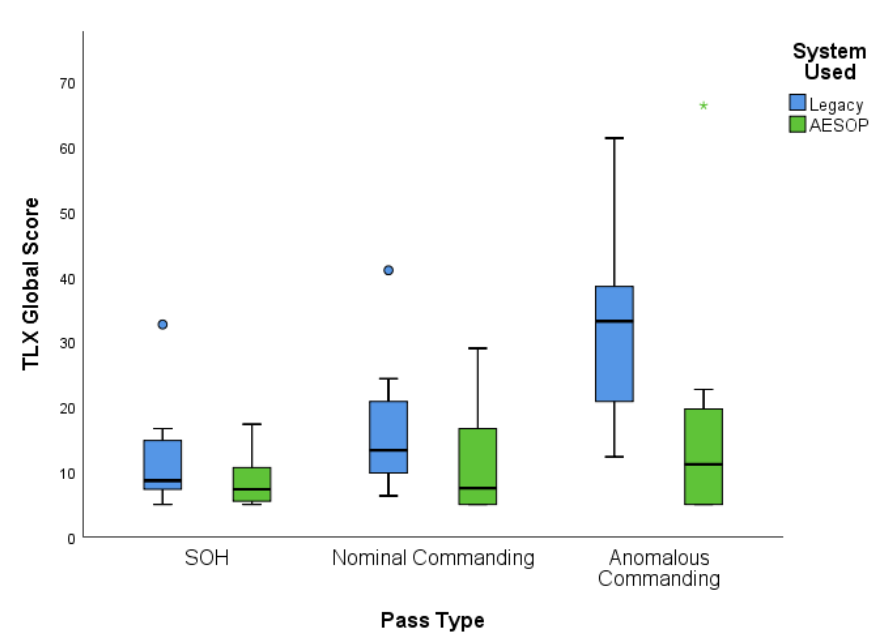
Figure 4. Anomaly Diagnosis Time in Both HMIs.